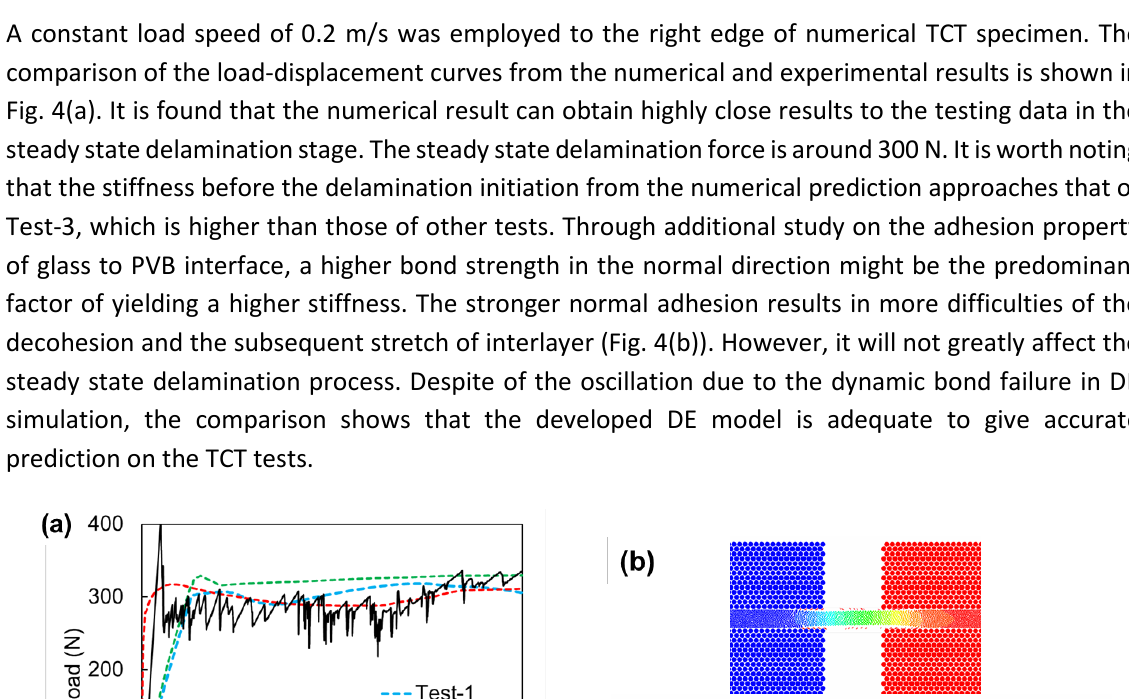
DE modelling of MTCT